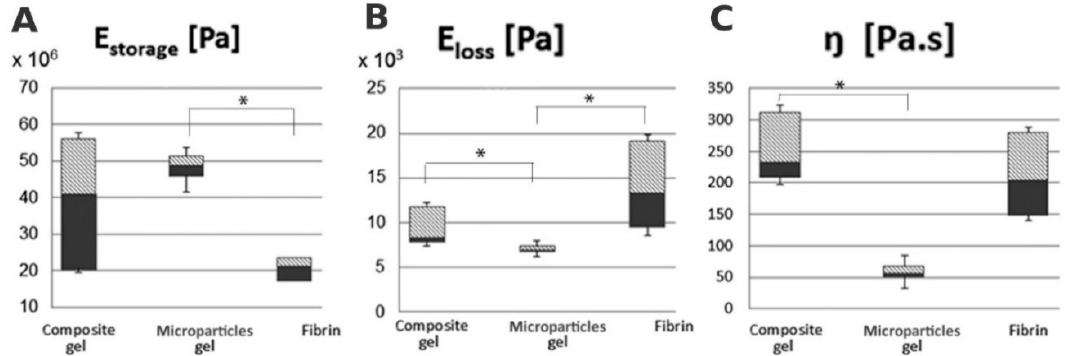
Figure 5. Viscoelastic properties of composite gel, microsphere gel (composite gel with PCL-Chit MPs) and fibrin were evaluated by dynamic tests, E storage ( A ), E loss ( B ) and viscosity ( C ) (* p < 0.05).